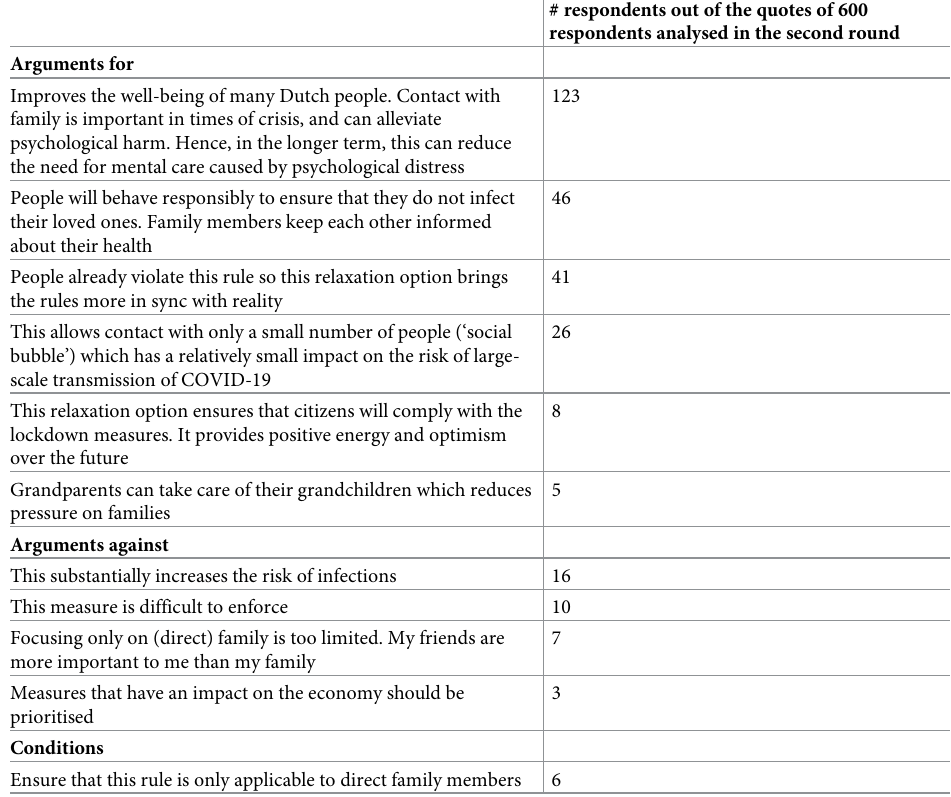
# respondents out of the quotes of 600 respondents analysed in the second round